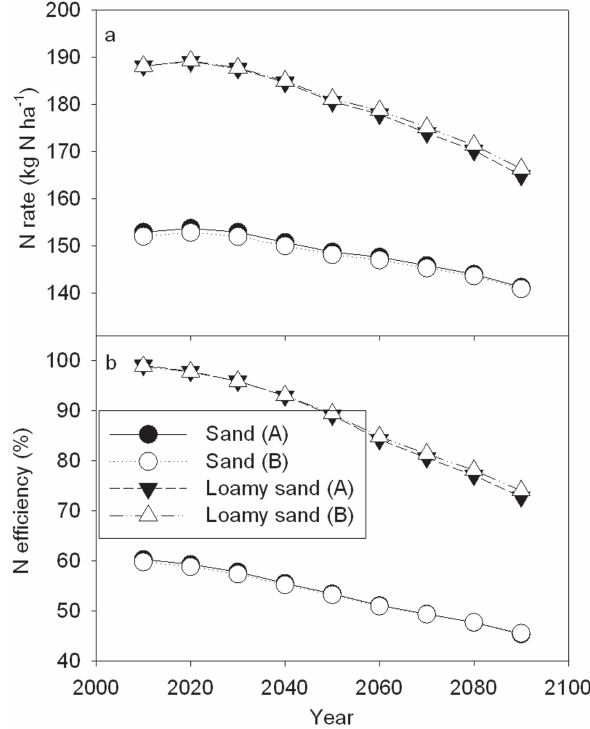
Fig. 7. N fertilization rate optimized to the annual mean yields and the N use efficiency (N in grain harvested divided by N fertilization rate). Results were calculated for projected climate conditions at 10-yr intervals during the 21st century for the A1B emission sce- nario using methodologies A and